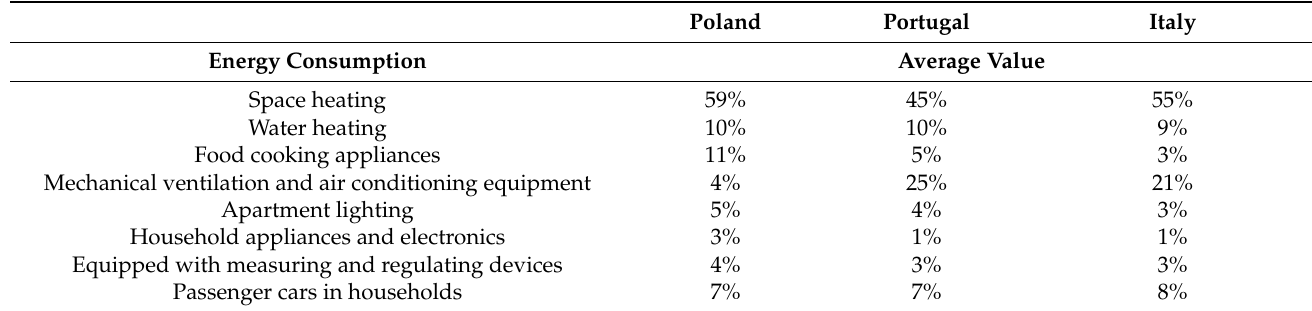
Table 2. Energy consumption of household appliances (data from 2020).